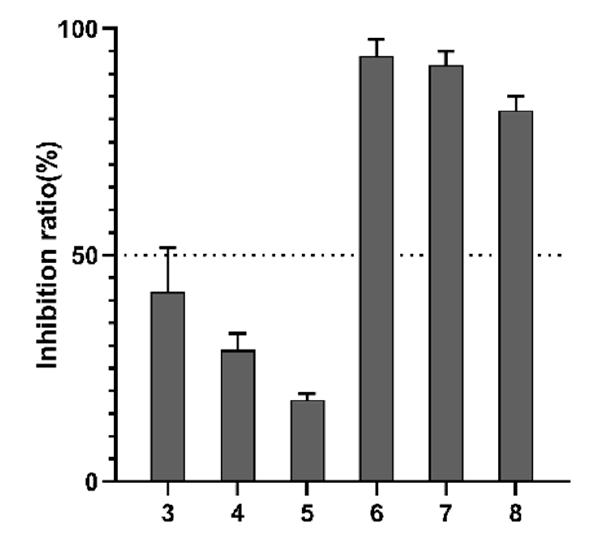
Figure 5. Effects of compounds 3 – 8 on current Ca v 3.1 low-voltage-gated calcium channel at 50 μ M. All the data were represented as mean ± SD ( n = 3).